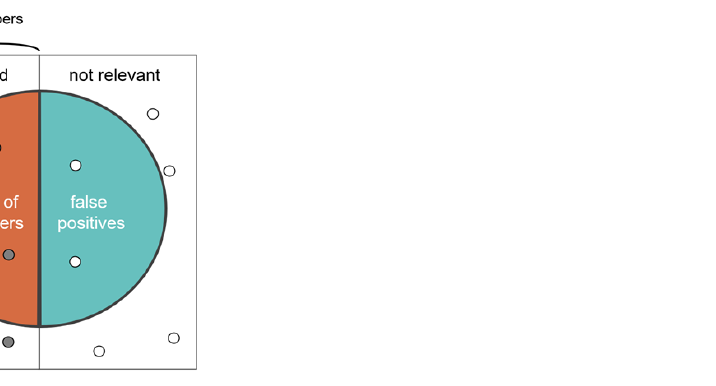
Figure 7. Precision and recall in scoping assessment strategy. Adapted from https://commons.wiki-